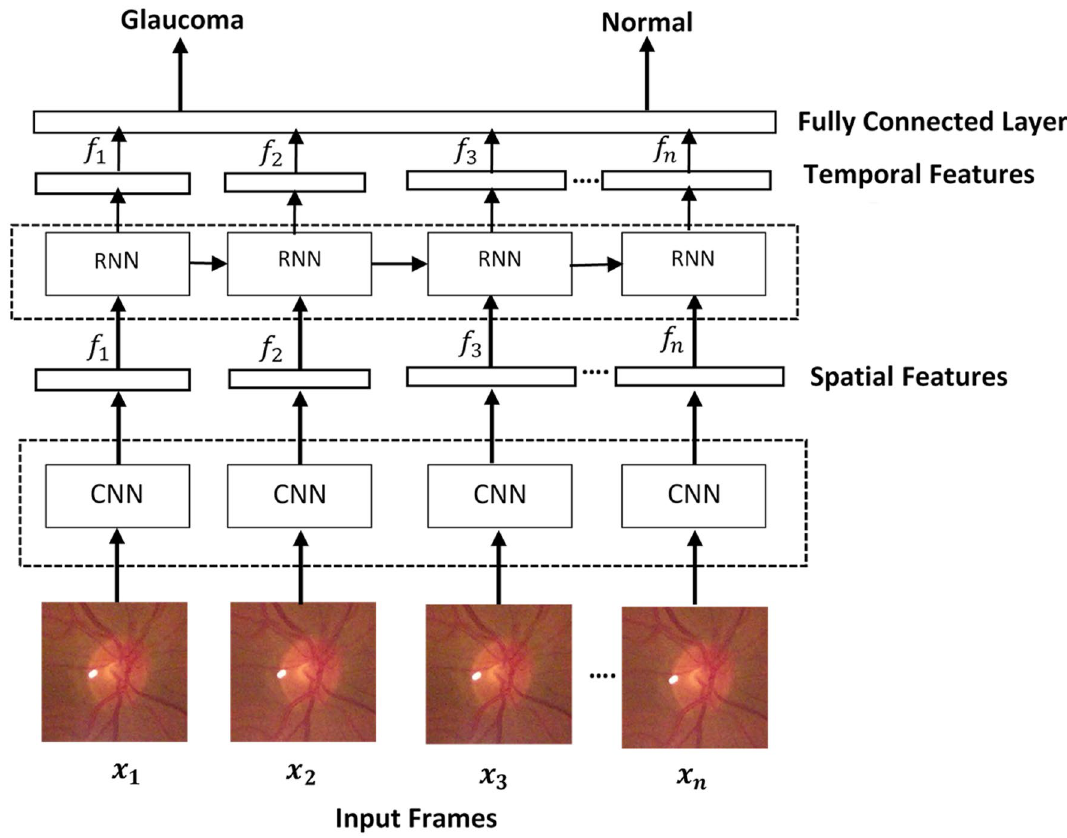
Figure 4. Overall framework of the fused Convolutional Neural Network-Recurrent Neural Network (CNN- RNN). The extracted spatial features from the CNN passes through the RNN to create the temporal